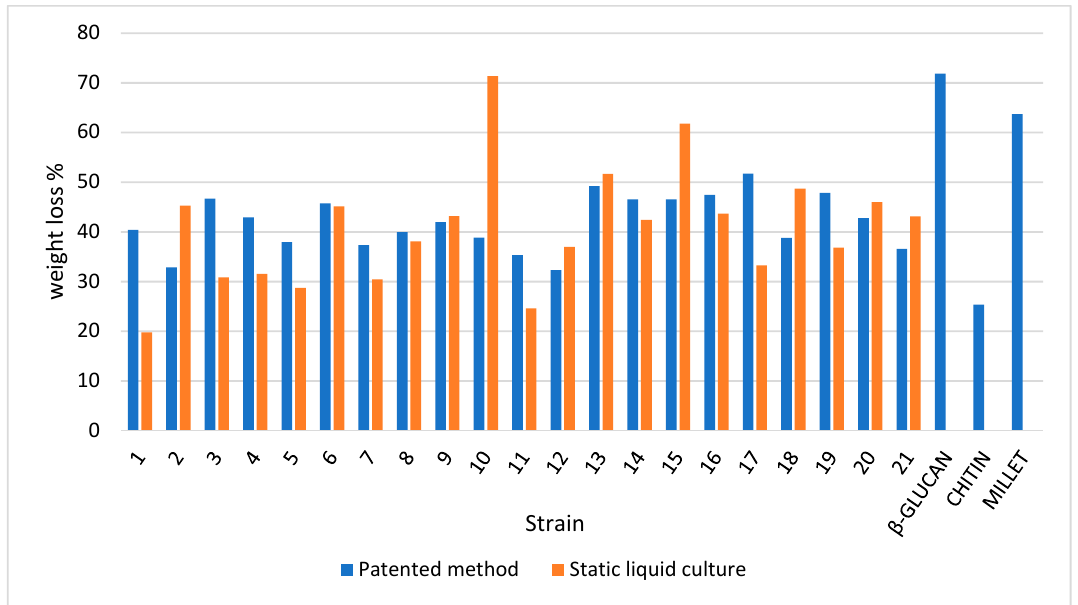
Figure 7. Weight loss percentage for the dry samples in the 250–350 ◦ C temperature range (TGA output) in the mycelium (pure mycelium and slurry mat) and reference